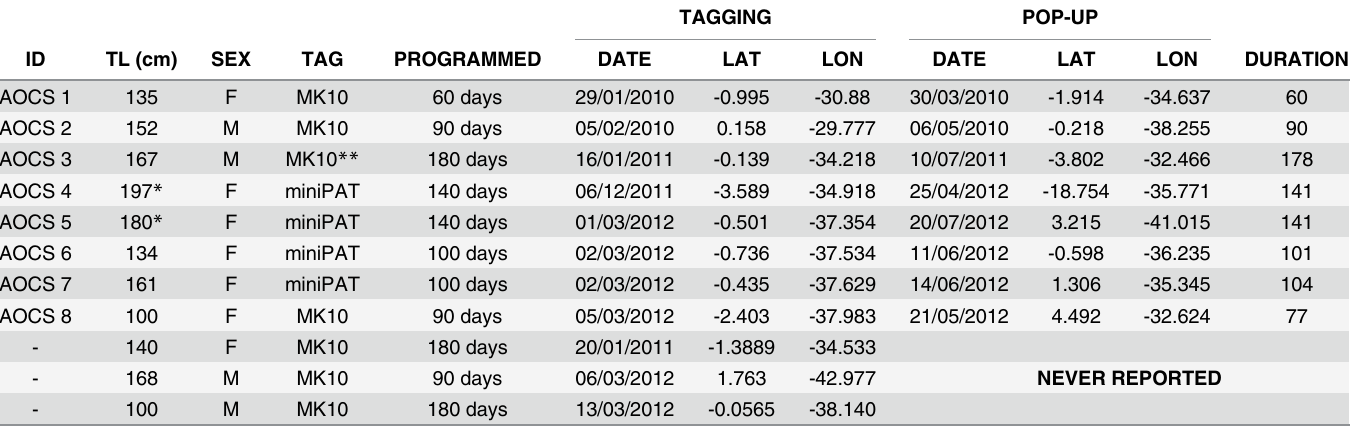
Table 1. Meta data of the oceanic whitetip sharks tagged in the western Atlantic Ocean.